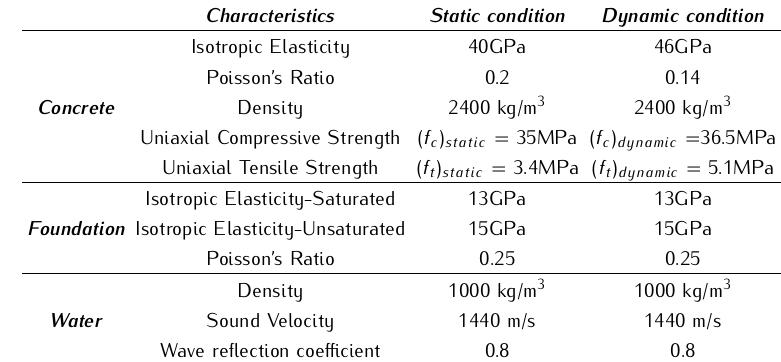
Table 2. Material properties of mass concrete, foundation rock and reservoir water.